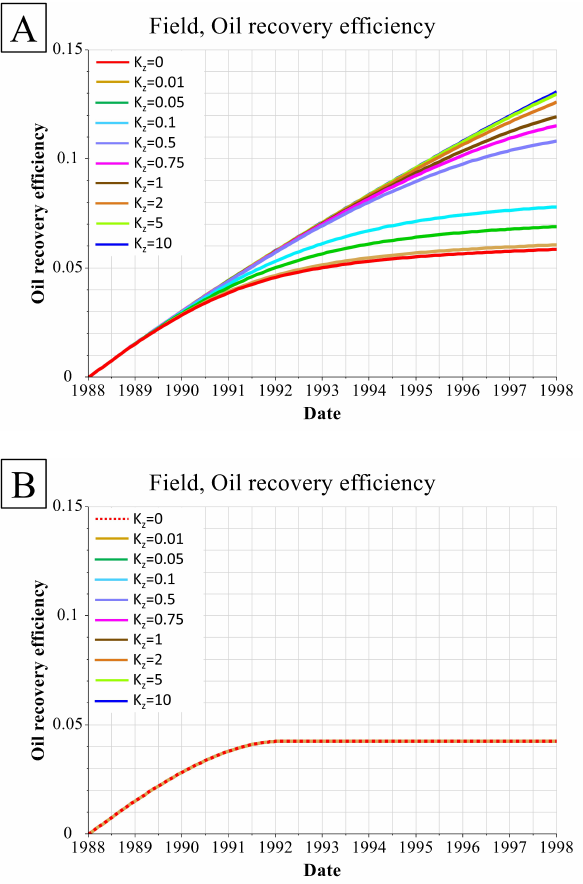
Figure 6. The effect of vertical matrix permeability ( k z ) on the ultimate oil recovery of the model using ( A ) Alternative Gravity Drainage–Quandalle and Sabathier formulas, which obtained various field performances, compared to ( B ) Gravity Drainage–Gilman and Kazemi formulas, where oil recovery was not affected by vertical permeability, as illustrated by similar performance of various K z